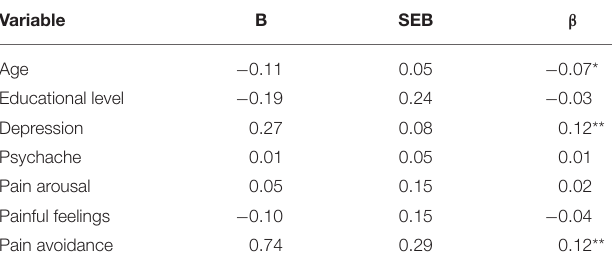
TABLE 3 | Summary of simultaneous multivariate regression results for variables predicting BSI-C scores.